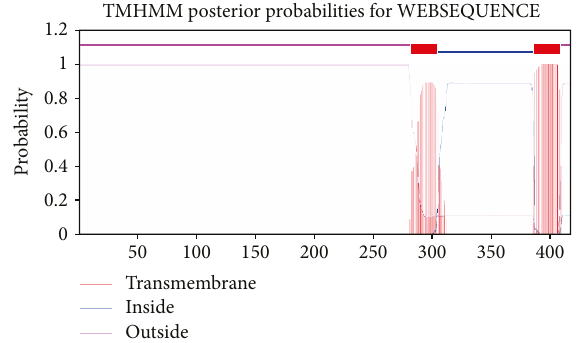
Figure 4: TMPRED and TMHMM predictions for transmembrane proteins. Two transmembrane regions (285-301 and 389-408) displayed a probability ≥ 0 8 and a score that exceeded 500, strongly indicating the presence of transmembrane